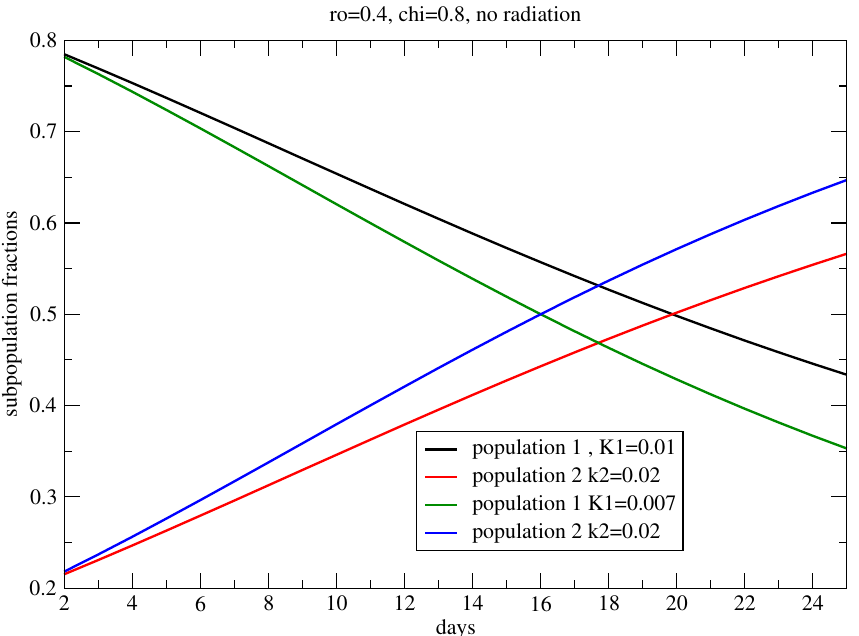
Figure 1. The fraction of the total number of cells of the two strains, growing with different specific rates. Two fractions, 80%/20% of N 0 and 40%/60% of N ∞ , with k α = 0.3 Gy ( − 1 ) , β = 0.03 Gy ( − 2 ) . k the standard treatment of 25